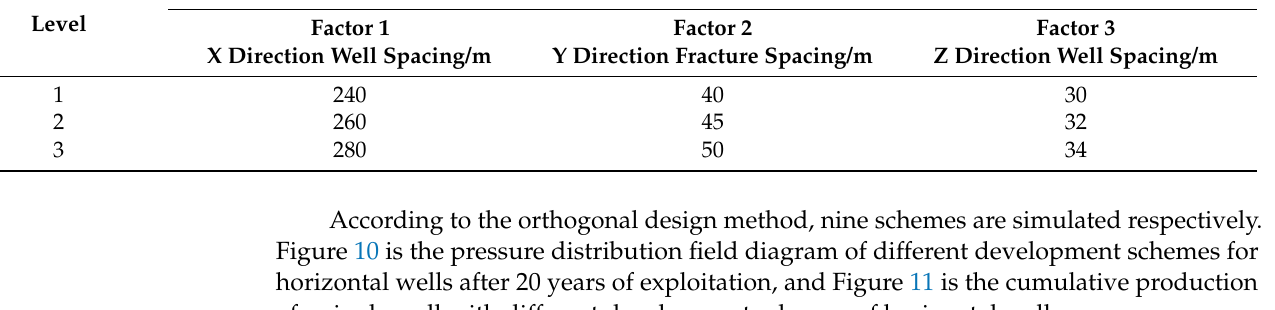
( d ) ( e ) Figure 9. ( a ) model porosity field diagram; ( b ) model permeability field diagram; ( c ) horizontal well